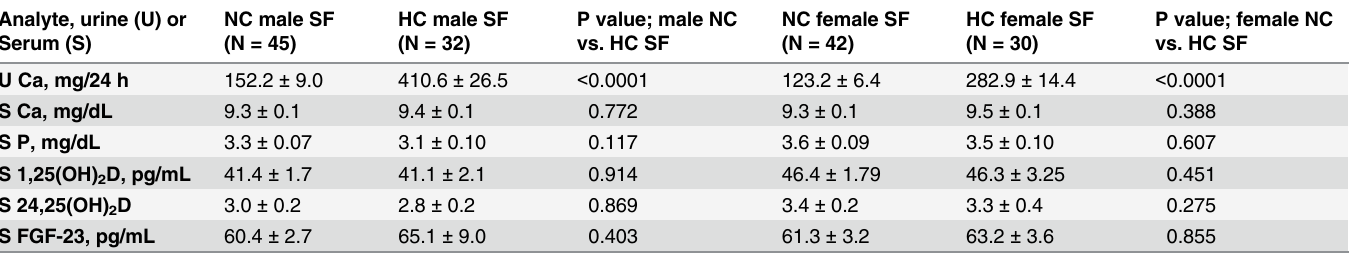
Table 3. Urine Ca and serum analytes in male and female normocalciuric SF (NC; males, U Ca < 250 mg/ 24 h; females U Ca < 200 mg/24 h) or hyper- calciuric SF (HC; male U Ca > 250 mg/24 h; female U Ca > 200 mg/24 h); mean +/- SEM. Analyte, urine (U) or NC male SF Serum (S) (N =